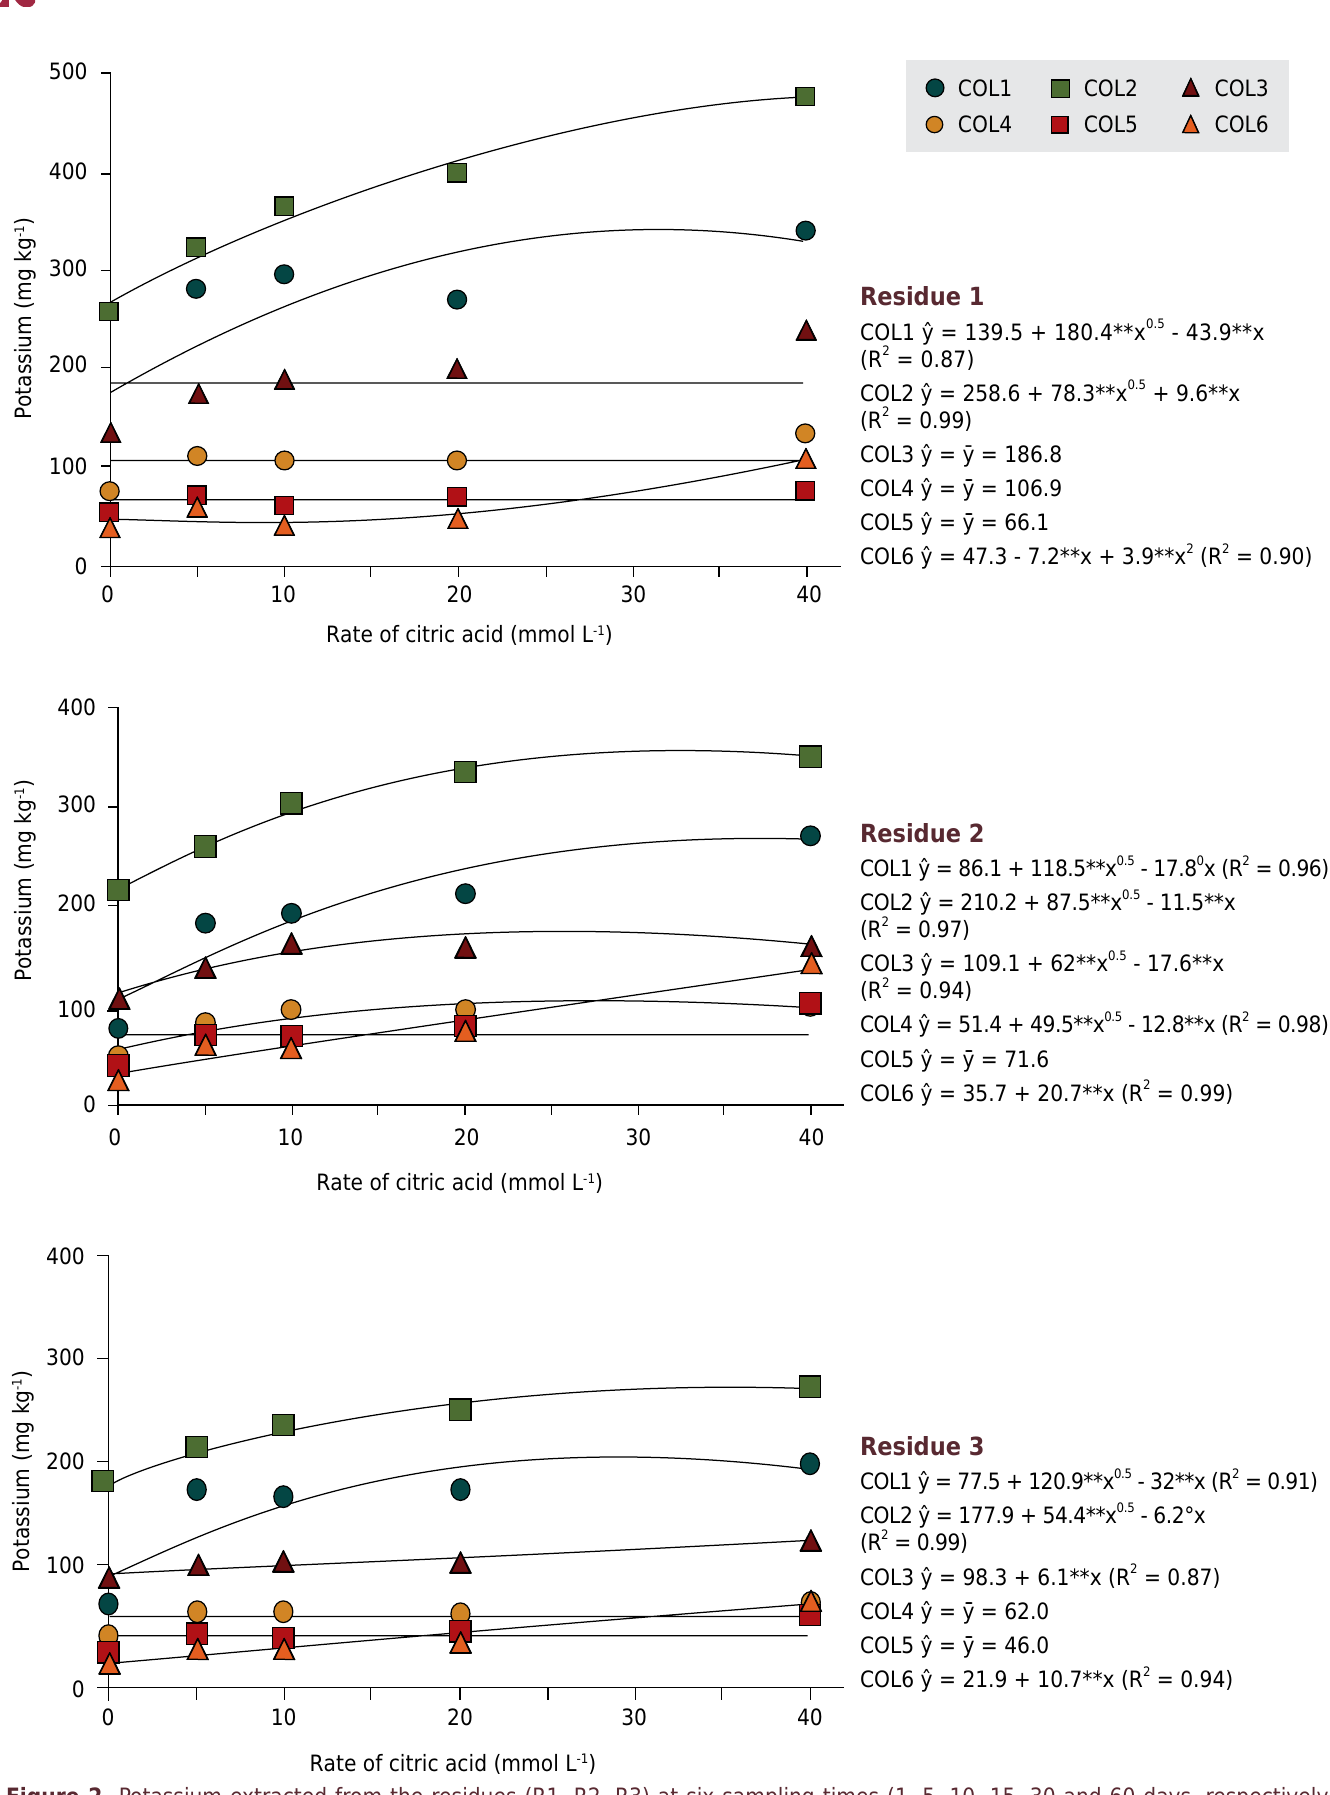
Figure 2. Potassium extracted from the residues (R1, R2, R3) at six sampling times (1, 5, 10, 15, 30 and 60 days, respectively, COL1, COL2, COL3, COL4, COL5, COL6), with the application of different rates of citric acid (CA). **, * and °: significant at 1, 5 and 10 %,